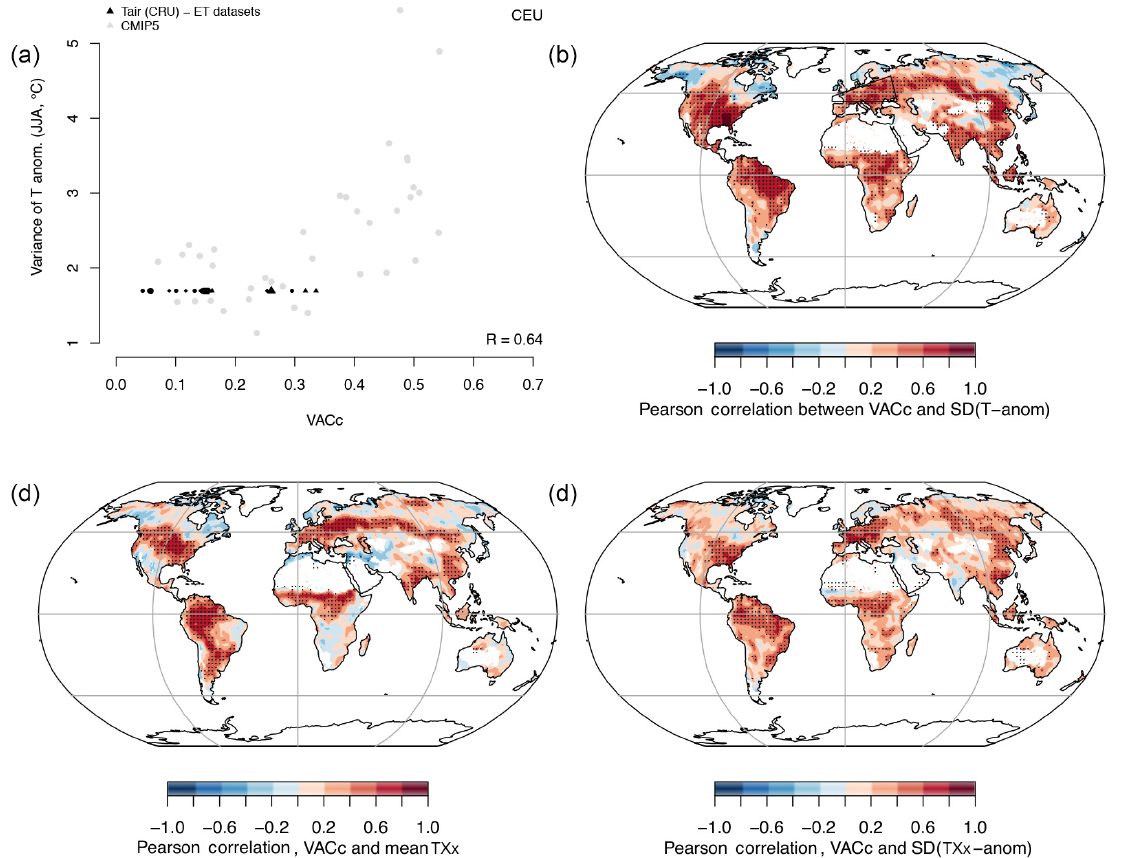
Figure 3. (a, b) Relationship between model-specific T –ET coupling (expressed through VACc) and model-simulated variability in monthly temperature anomalies (JJA) in central Europe (a) and globally (b) . (c, d) Relationship betweeen VACc coupling and mean (c) and standard deviation (d) of simulated monthly maximum value of daily maximum temperature (TXx) in summer